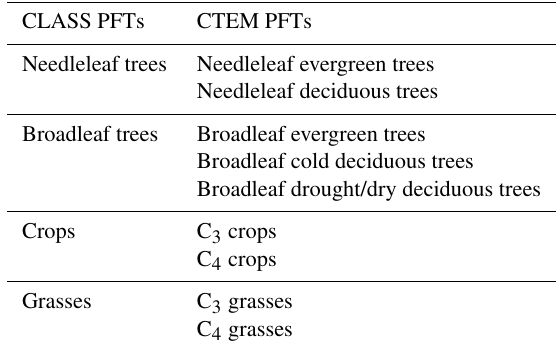
Table 1. Plant functional types (PFTs) represented in CTEM and their relation to CLASS